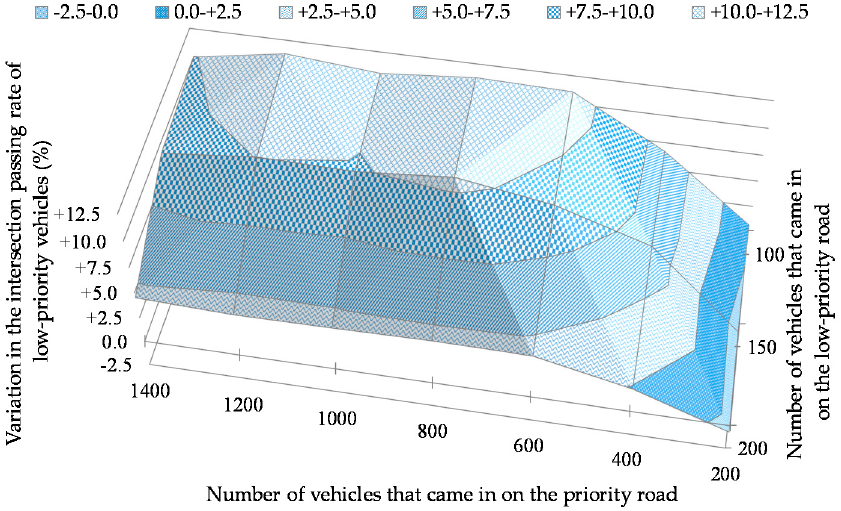
Figure 10. Variation in the intersection passing rate of low-priority vehicles when the number of vehicles that came in were varied. The intersection passing rate was the average for the entire percentage range of self-driven vehicles.